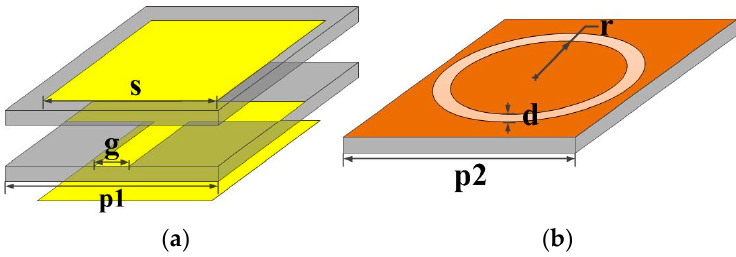
Figure 1. ( a ) Subwavelength multilayer patch and grid frequency selective surface (FSS), ( b ) resonant complementary loop FSS (The grey represents substrates, the yellow and orange parts represent metal).